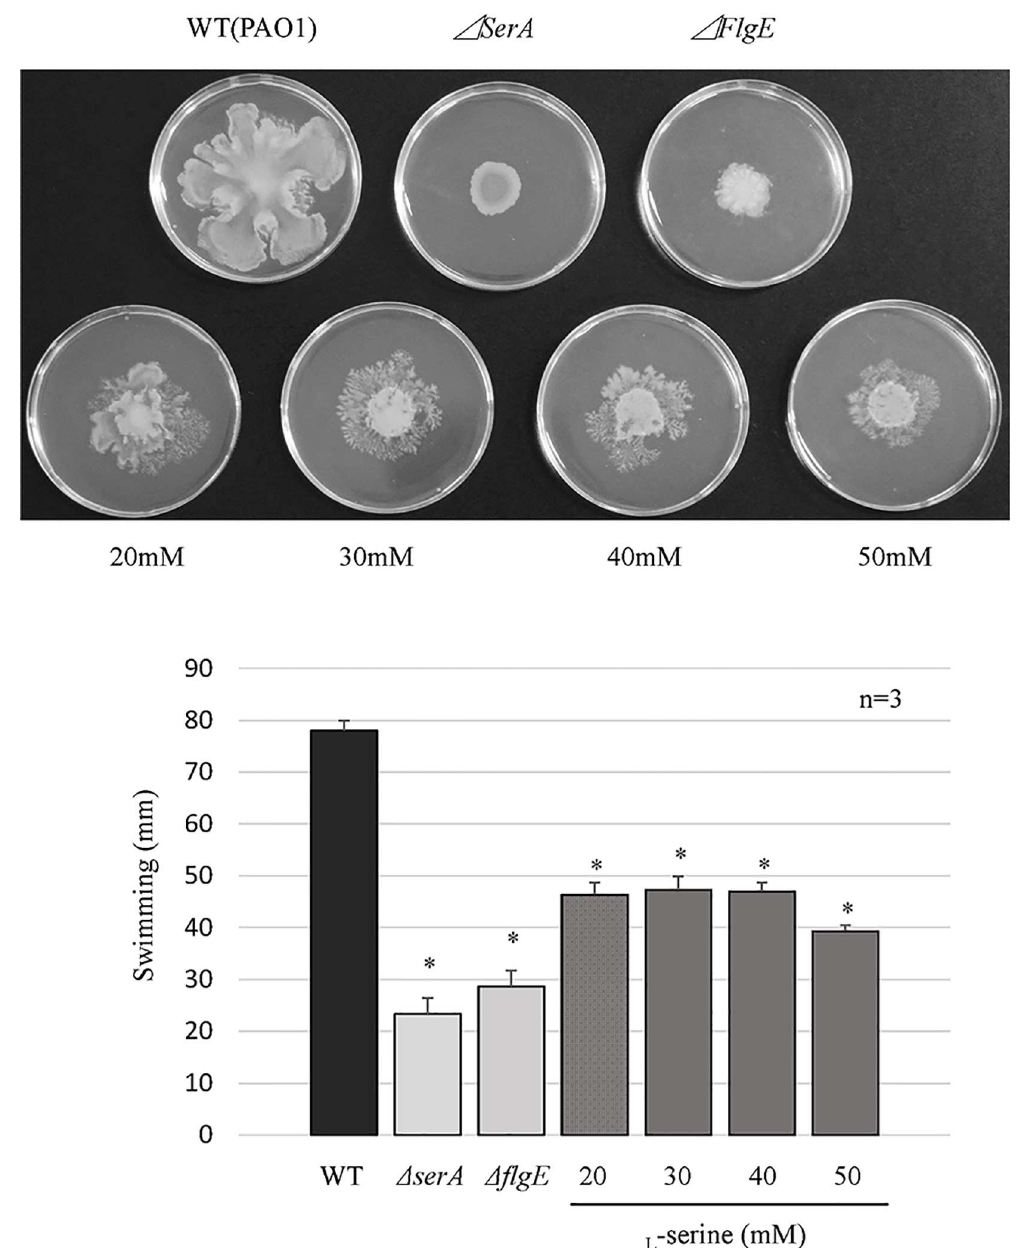
Fig 5. Influence of L -serine addition on swimming motility in the wild-type strain. Swimming motility in the wild-typestrain (WT), PAO1Tn:: serA mutant ( Δ serA ),PAO1Tn:: flgE mutant ( Δ flgE )(as a negative control), and WT in the presenceof L -serine (20, 30, 40, and 50 mM). A representative image from the swarmingmotility assay is shown. The major axis of swimming is the longestlength of the swimmingarea. The assay was performed in triplicate, and the results are expressedas the mean ± SD. Significantdifferences were observed betweenWT and Δ serA ( * : P < 0.05), betweenWT and Δ flgE ( * : P < 0.05), betweenWT and WT in the presenceof 20 mM L -serine ( * : P < 0.05), betweenWT and WT in the presenceof 30 mM L -serine ( * : P < 0.05), betweenWT and WT in the presenceof 40 mM L -serine ( * : P < 0.05), and betweenWT and WT in the presenceof 50 mM L -serine ( * : P <